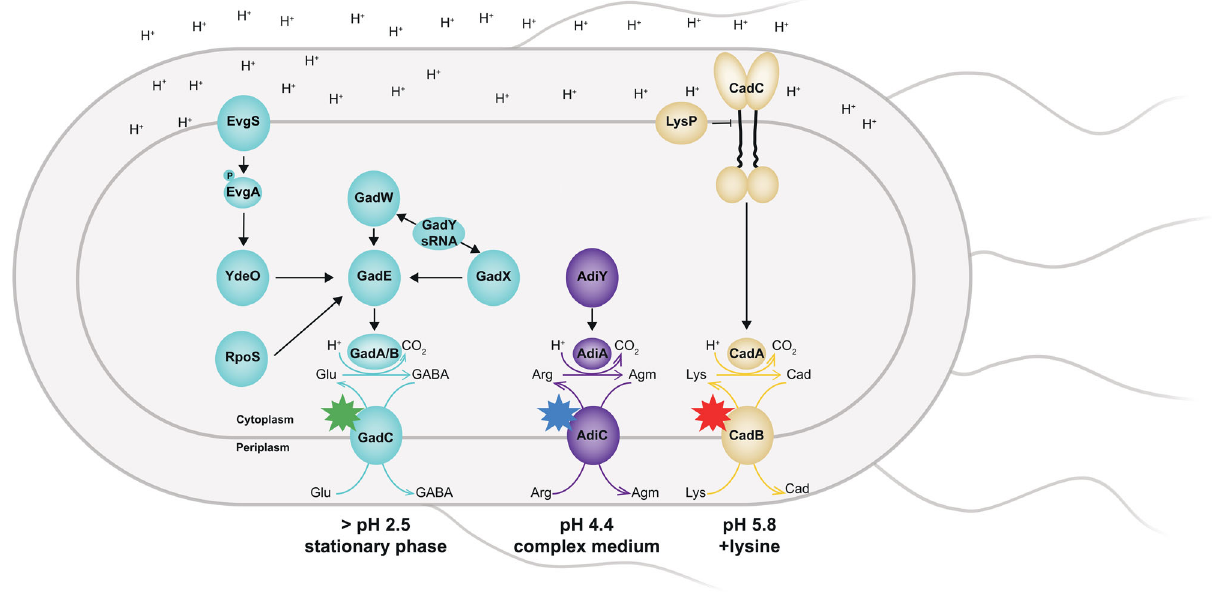
Fig. 1 The regulatory network of inducible amino acid decarboxylase-antiporter systems in E. coli three-color strain. Regulated induction of the Gad (blue symbols), Adi (purple symbols), and Cad (yellow symbols) systems requires a network of membrane-integrated pH-sensors, namely EvgS and CadC; interconnected transcription factors; and the sRNA GadY. The glutamate decarboxylases GadA and GadB convert glutamate (Glu) into γ -aminobutyrate (GABA), which is excreted by GadC. The arginine decarboxylase AdiA converts arginine (Arg) into agmatine (Agm), which is excreted by AdiC. The lysine decarboxylase CadA converts lysine (Lys) into cadaverine (Cad), which is excreted by CadB. Adapted from 3, 15, 24, 25, 47, 74 . The stimuli leading to an induction of each of the three AR systems is indicated below each system. Each fl uorescent hybrid of the three antiporter is indicated with a star symbol: GadC:eGFP (green star), AdiC:mCerulean (blue star), and CadB:mCherry (red star) according to the hybrid with the fl uorophore eGFP, mCerulean, and mCherry,